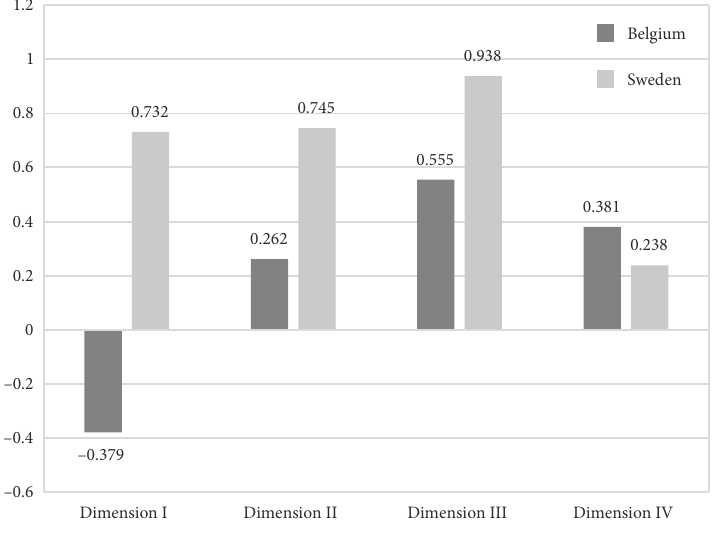
Figure 2. Results of Belgium and Sweden